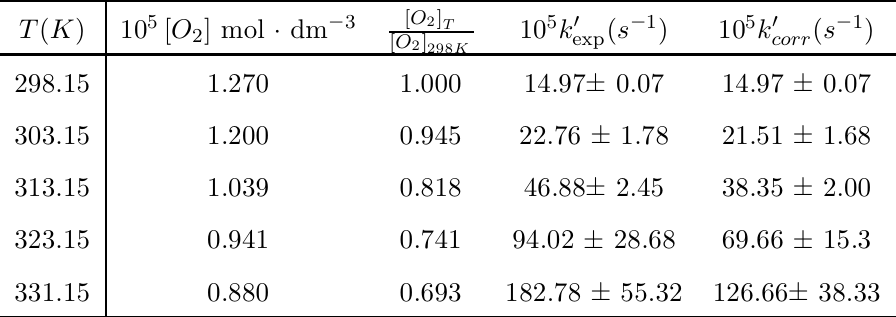
Table 3 Variation of pseudo-› rst rate constant with temperature at pH